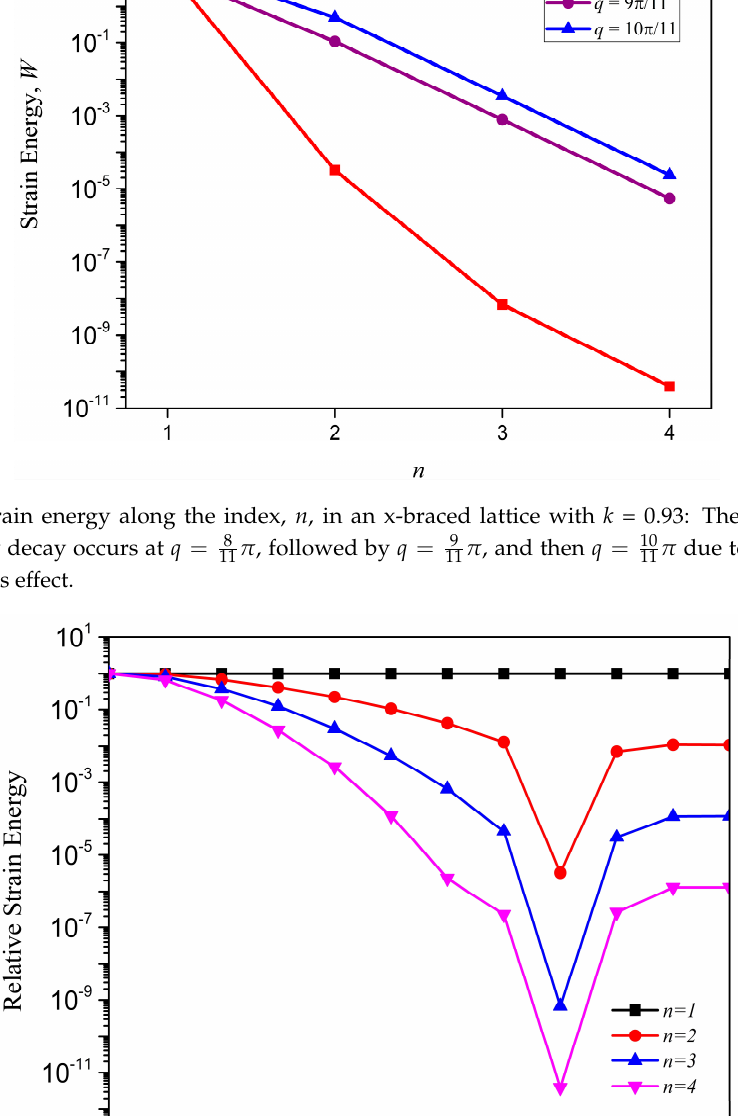
Figure 9. Strain energy along the index, n , in an x-braced lattice with k = 0.93: The fastest total strain energy decay occurs at 𝑞 = Venant’s effect.